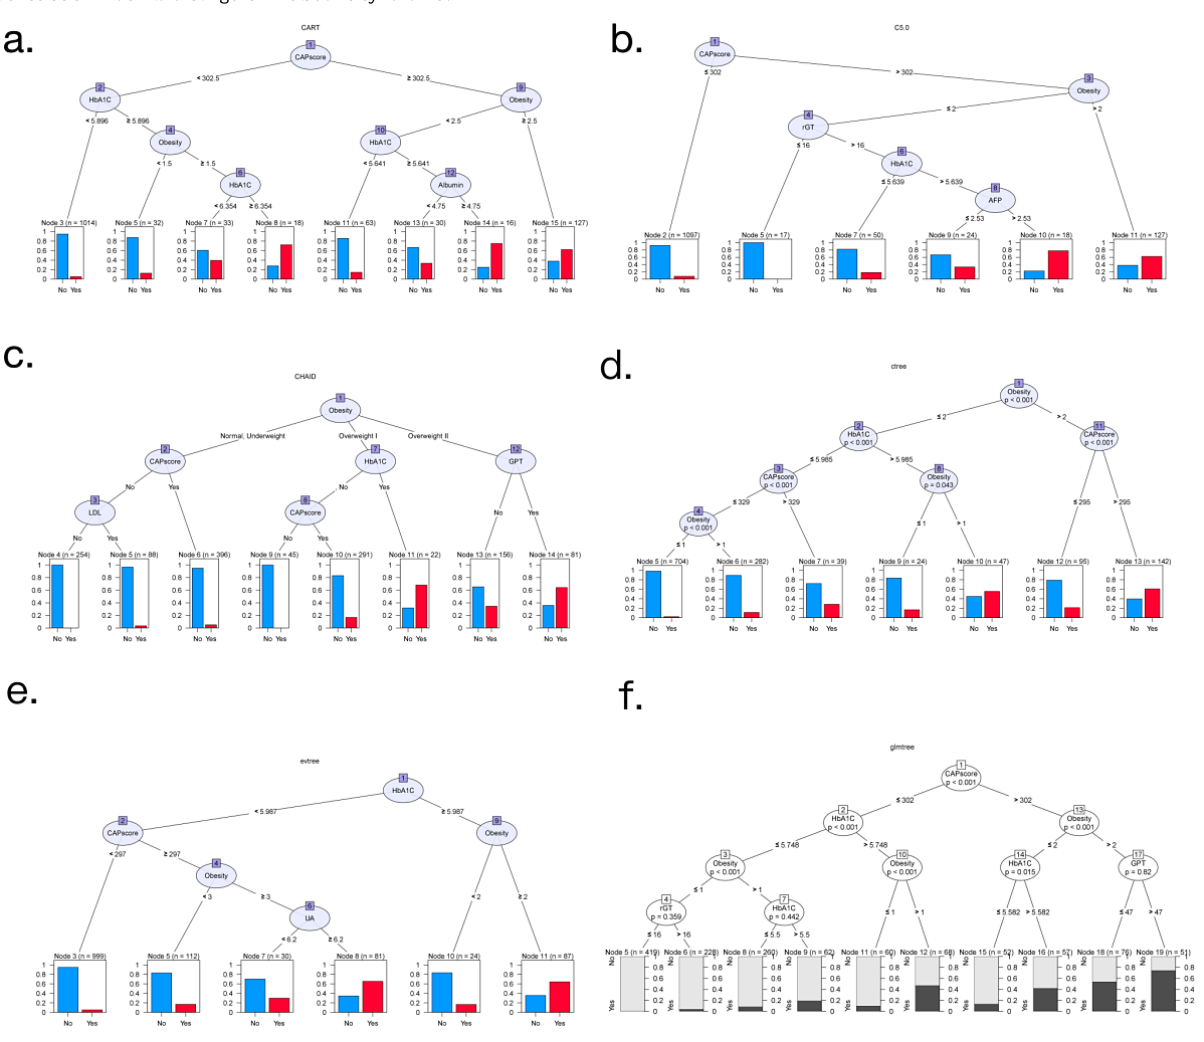
Figure 3. Metabolic syndrome prediction by various decision tree models. The decision tree takes on a flowchart-like structure. The six most commonly used decision trees are shown: (a) classification and regression tree (CART), (b) C5.0 classification tree modified from C4.5 and ID3 tree, (c) chi-square automatic interaction detection (CHAID), (d) conditional inference tree (ctree), (e) evolutionary learning of globally optimal tree (evtree), and (f) generalized linear model tree (glmtree). Each decision tree is applied for the prediction of metabolic syndrome to explore the factors with the greatest influence as an index to distinguish metabolic